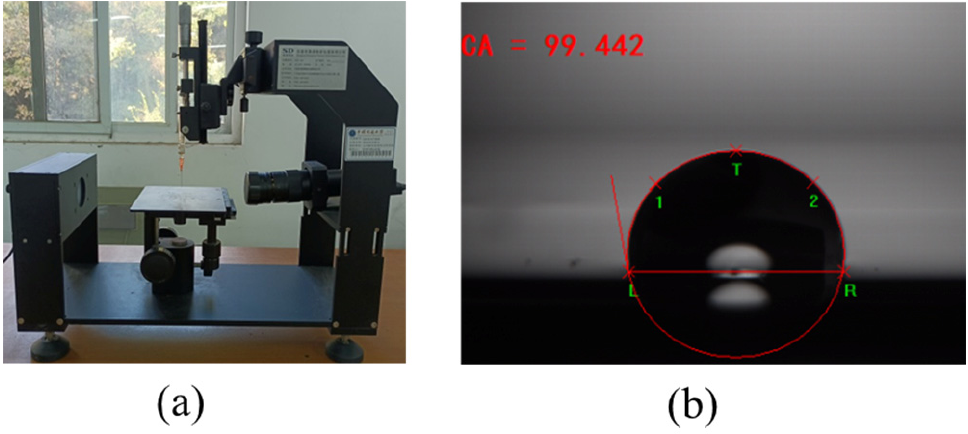
Figure 9. ( a ) The photo of contact angle instrument; ( b ) The photo of a liquid drop on the sample surface. Table 5. Surface free energy parameters of water and glycerin (25 °C, unit: mJ/m 2 ). Surface Free Energy Parameters